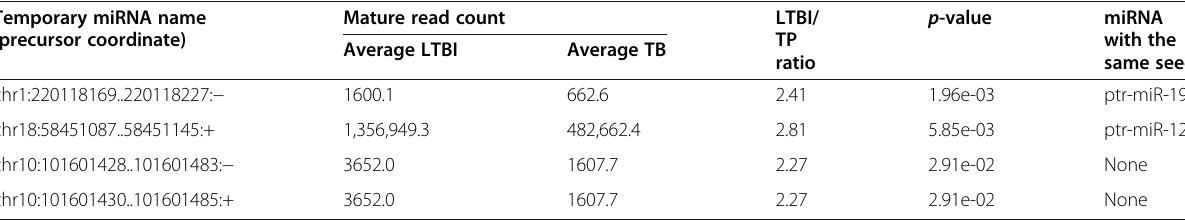
Mature read count LTBI/